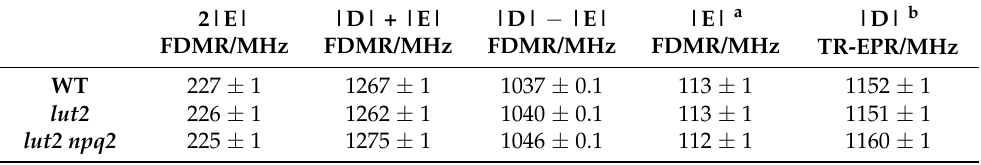
Table 1. ZFS parameters of 3 Car determined from the FDMR and TR-EPR experiments.